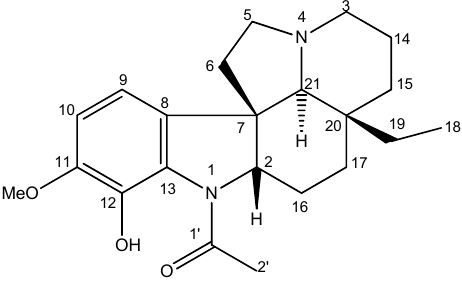
Figure 1. Chemical structure of Aspidocarpine.